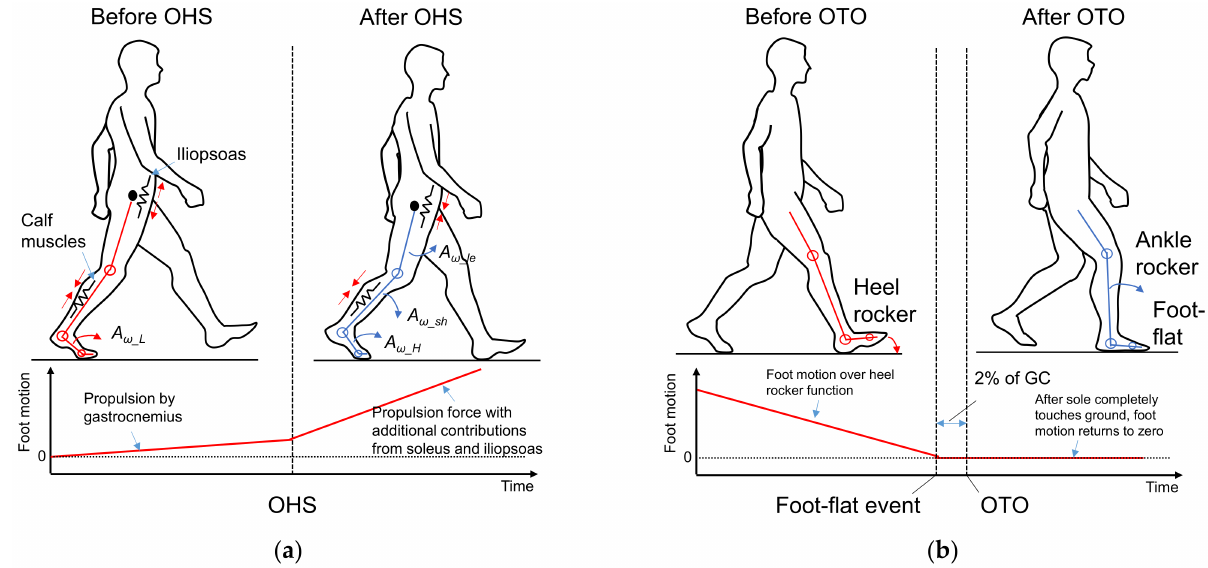
Figure 3. Foot motion analysis based on standard kinesiology knowledge: ( a ) foot motion near OHS, and ( b ) foot motion near